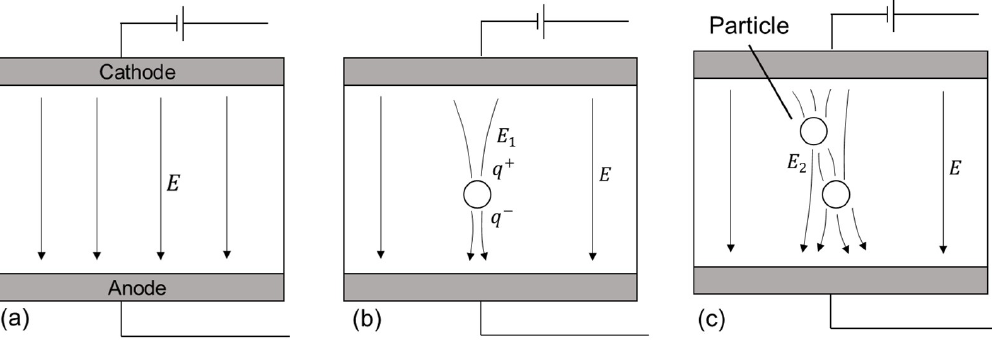
Figure 1. Schematic of ( a ) electric field in between two electrodes and ( b ) distortion due to presence of a single particle, ( c ) bridge formation with multiple